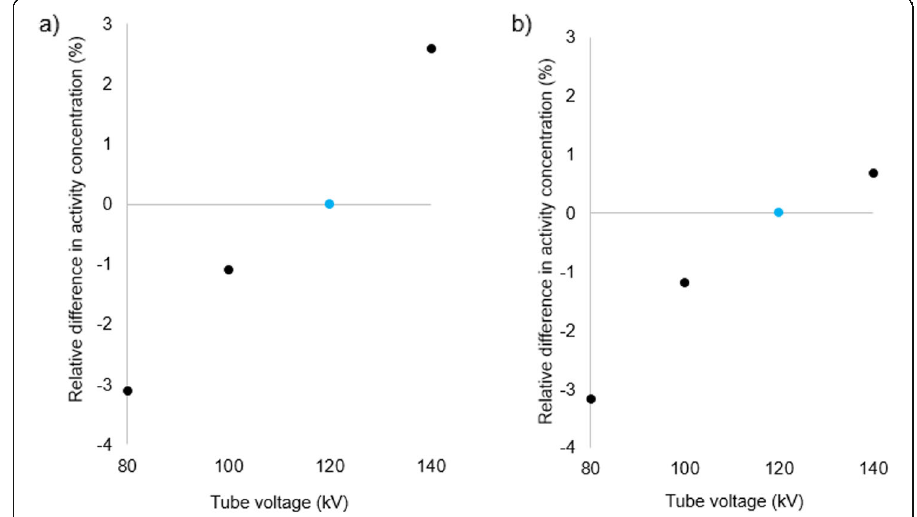
Fig. 4 Differences in a maximum and b mean activity concentration for each kV relative to 120 kV reference in Lungman plus fat. Data points also corresponding to ‘ CARE kV on ’ shown with blue